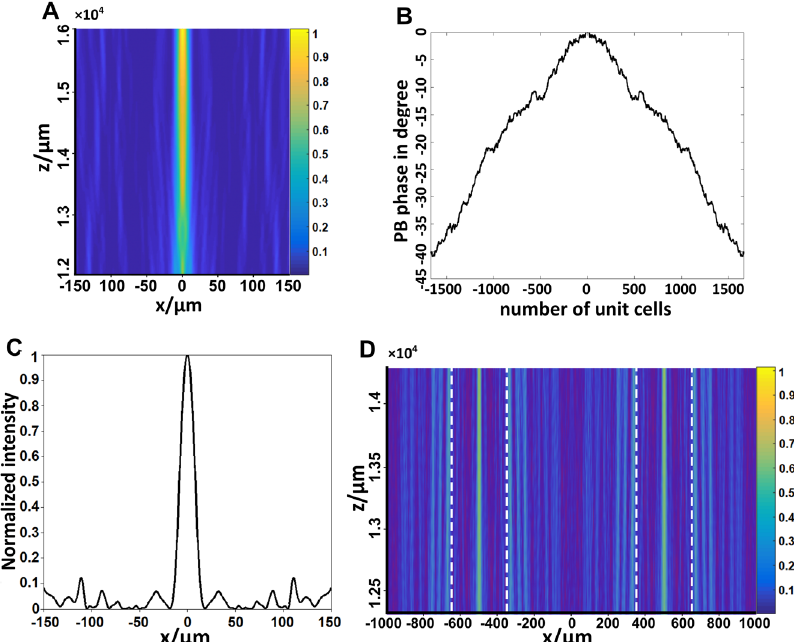
Figure 4: The GA-assisted design of a light- sheet pattern (A) with its corresponding phase profile for each unit cell (B) and the intensitydistributionat z =14mm(C),anda double-light-sheet pattern (D) created by applyingtheoptimizedphasepro fi leshown in